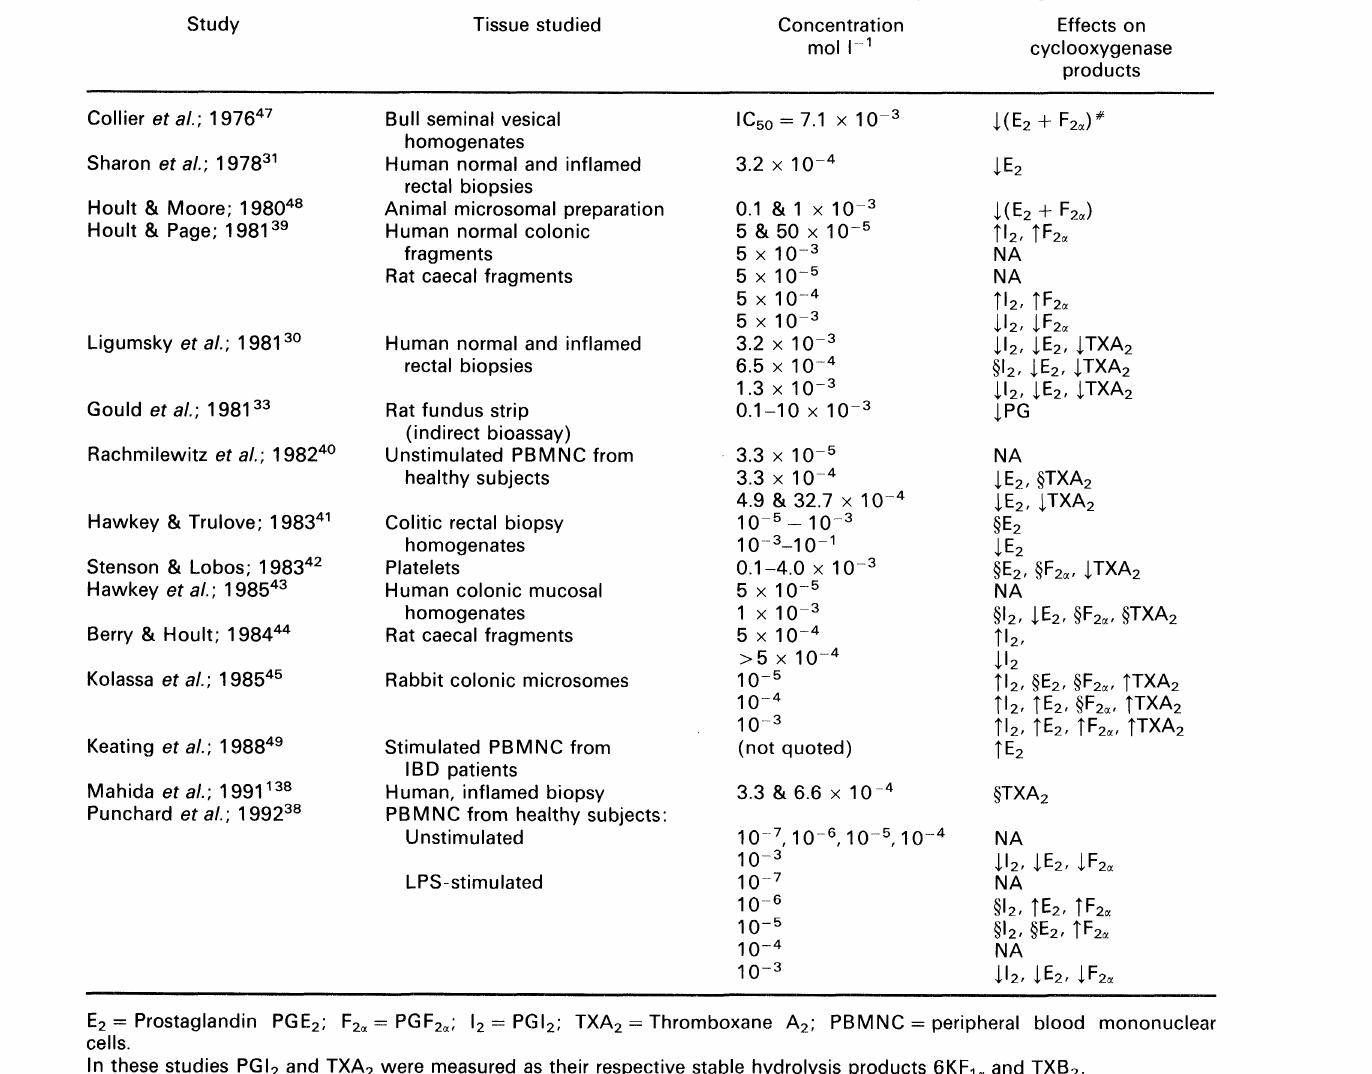
Table 2. In vitro studies of the effects of 5-aminosalicylic acid on prostaglandin and thromboxane production